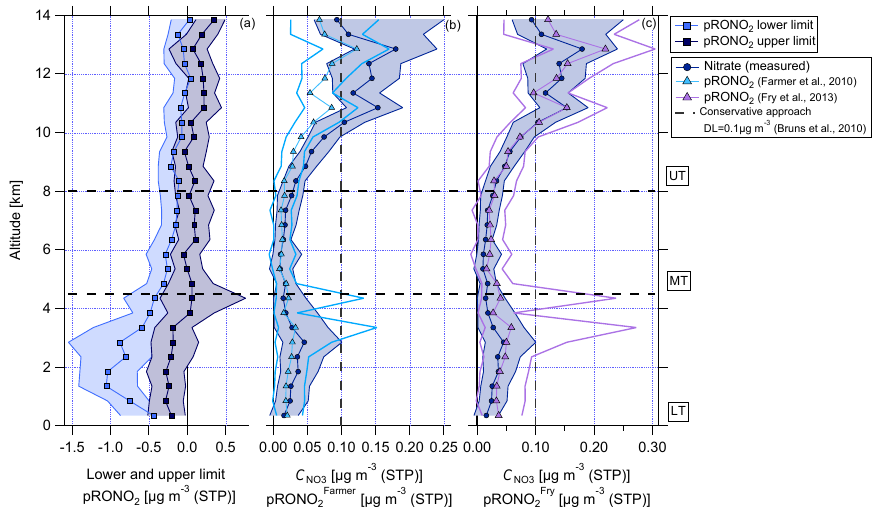
Figure 11. Vertical profiles of (a) calculated lower and upper limits of organic nitrate mass concentration (approach Sect. 3.4, this study), (b) measured nitrate mass concentration and organic nitrate mass concentration calculated according to Farmer et al. (2010), and (c) measured nitrate mass concentration and organic nitrate mass concentration calculated according to Fry et al. (2013). Horizontal dashed lines indicate the divisions into the LT with BL, MT, and UT. The vertical dashed line in panel (b) shows the conservative detection limit of 0.1µgm − 3 according to Bruns et al.